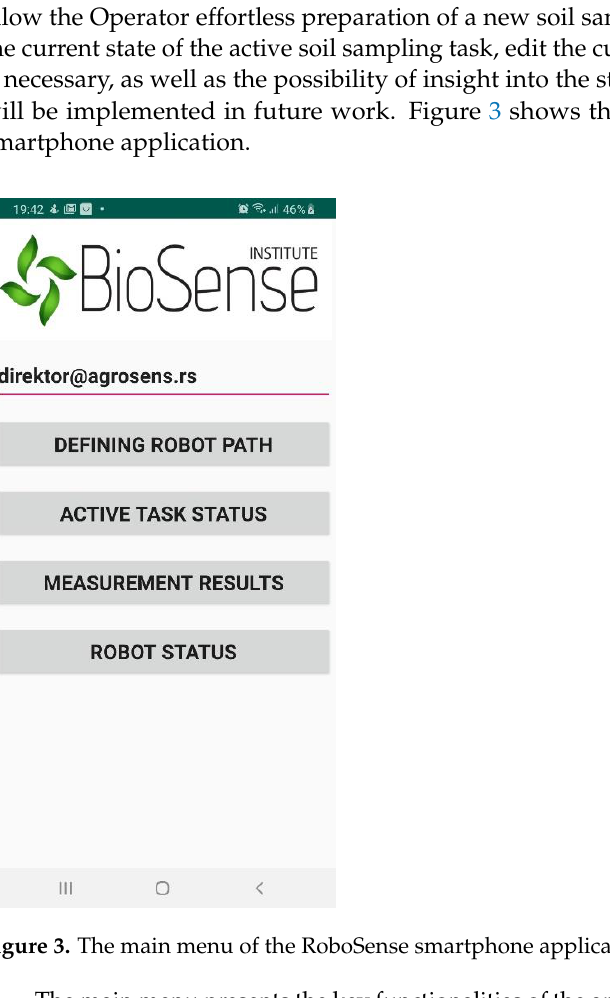
Figure 2. The results of the executed algorithm for proposing optimal sampling points within the AgroSense platform. Each color represents different management zones, while pin markers repre- sent the optimal sampling points per zone.